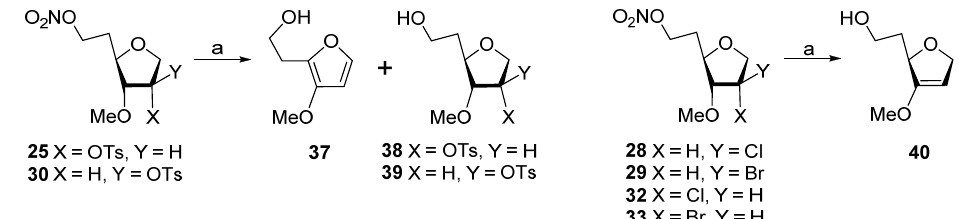
Table 2. Products from 3- O -methyl-6- O -nitro-1,4-anhydrohexitols